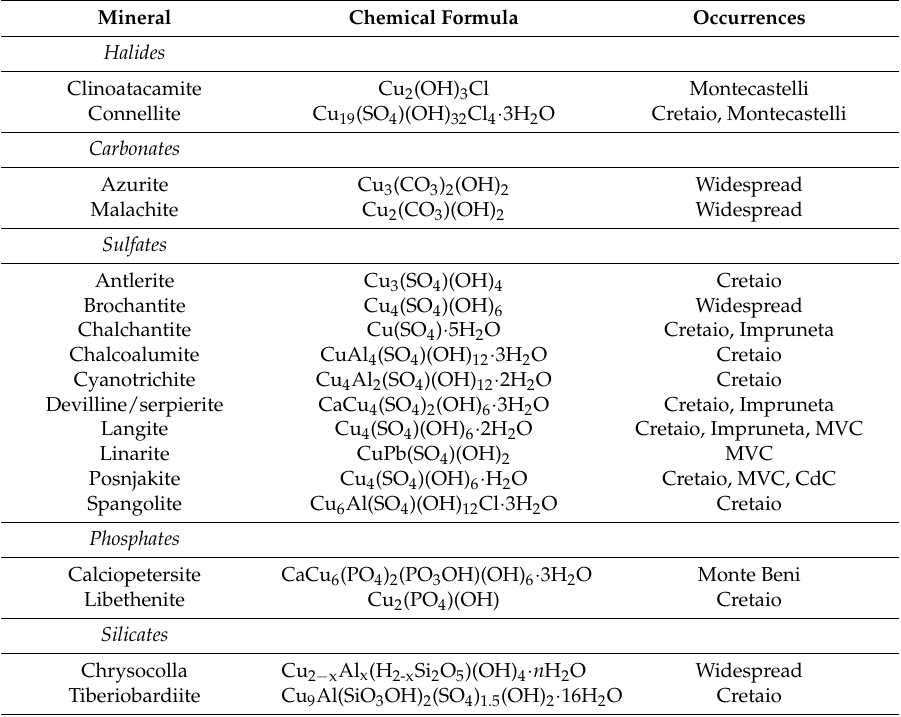
Table 9. Secondary Cu 2+ oxysalts in ophiolite-hosted ore deposits from